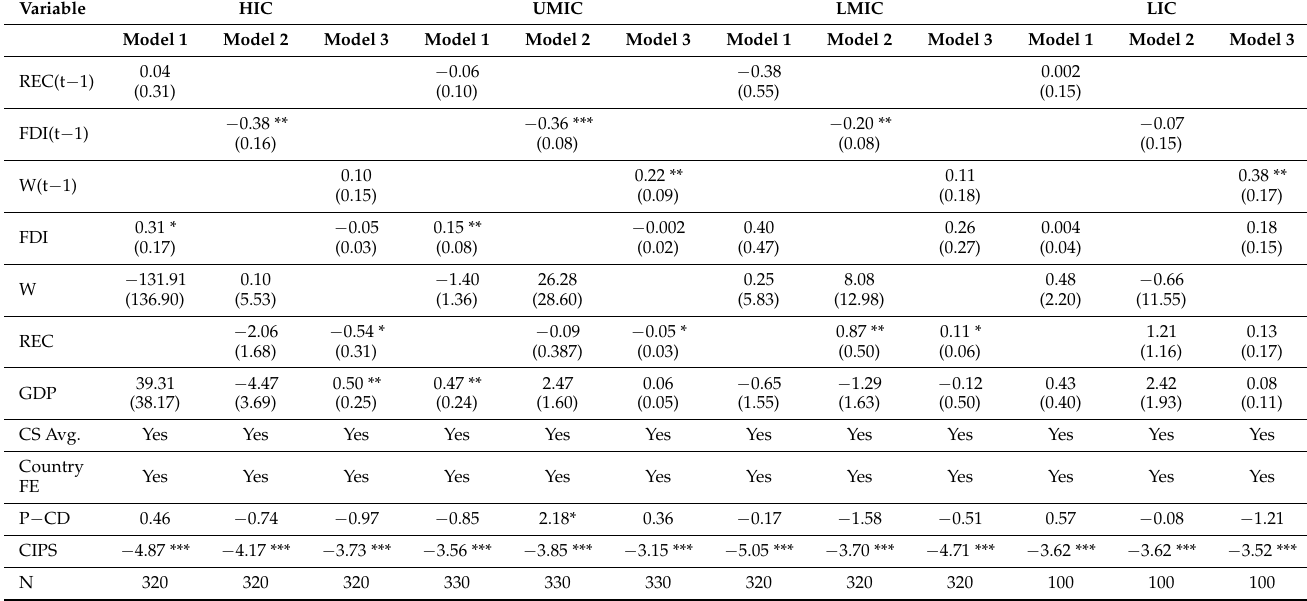
Table 6. Estimation of the Cointegrating